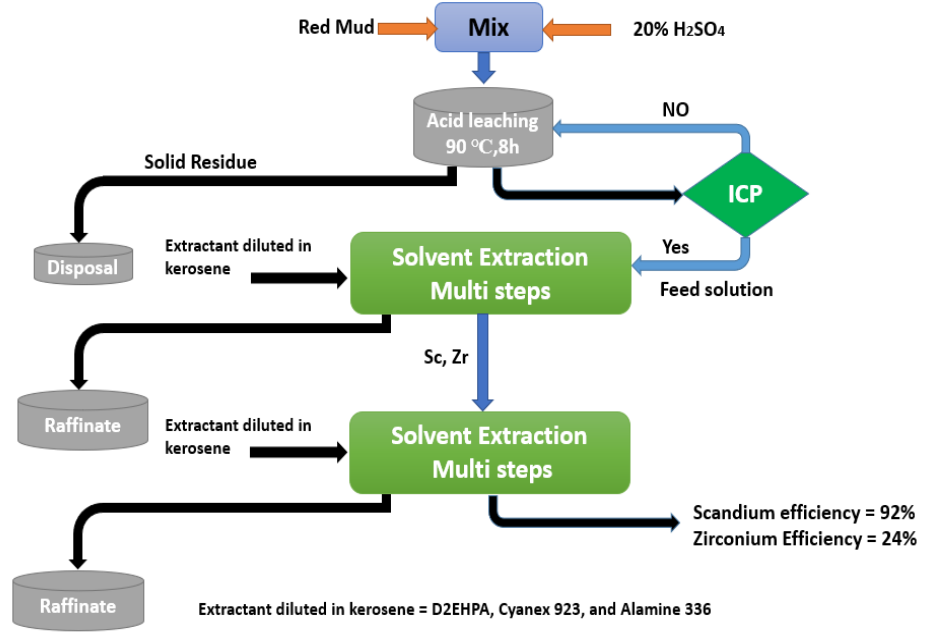
Figure 18. Flowchart proposed for Sc and Zr recovery from RM by SX, adapted from [150]. As a result, it is critical to investigate the best SX conditions in order to maximize the scandium recovery from RM while minimizing other metals. In another study, the selective extraction of scandium from the Greek RM was studied by Ochsenkühn et al. [151]. The flow chart of the procedures is shown in Figure 19.